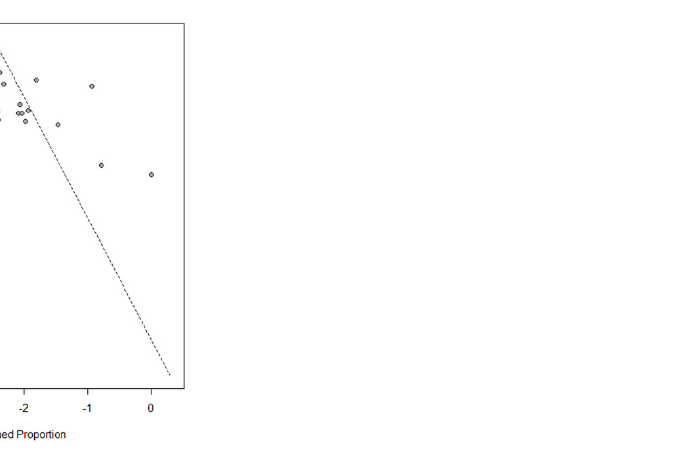
Figure 3. Funnel plot of the proportion of EBV+ DLBCL in the included studies. Note the absence of funnel plot asymmetry.